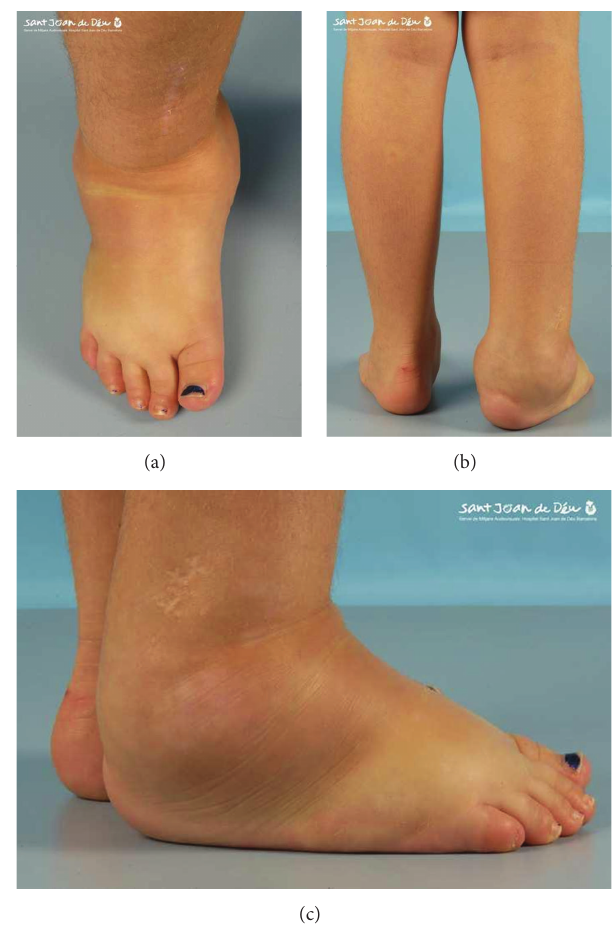
Figure 3: Lower limb edema.